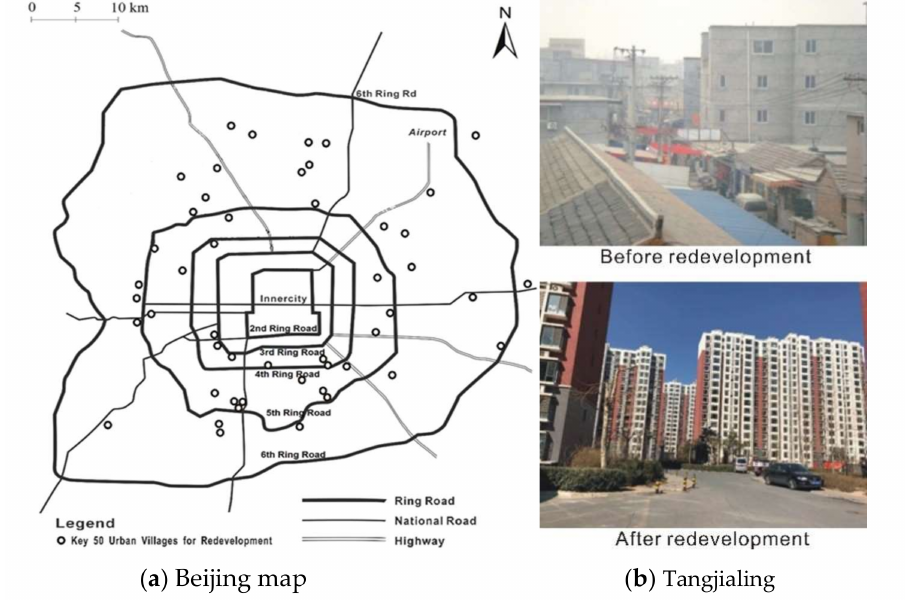
Figure 1. The 50 key urban villages identified for redevelopment in Beijing since 2010 (Source: the name list of the 50 key urban villages is from News. Focus [27]; field trip by